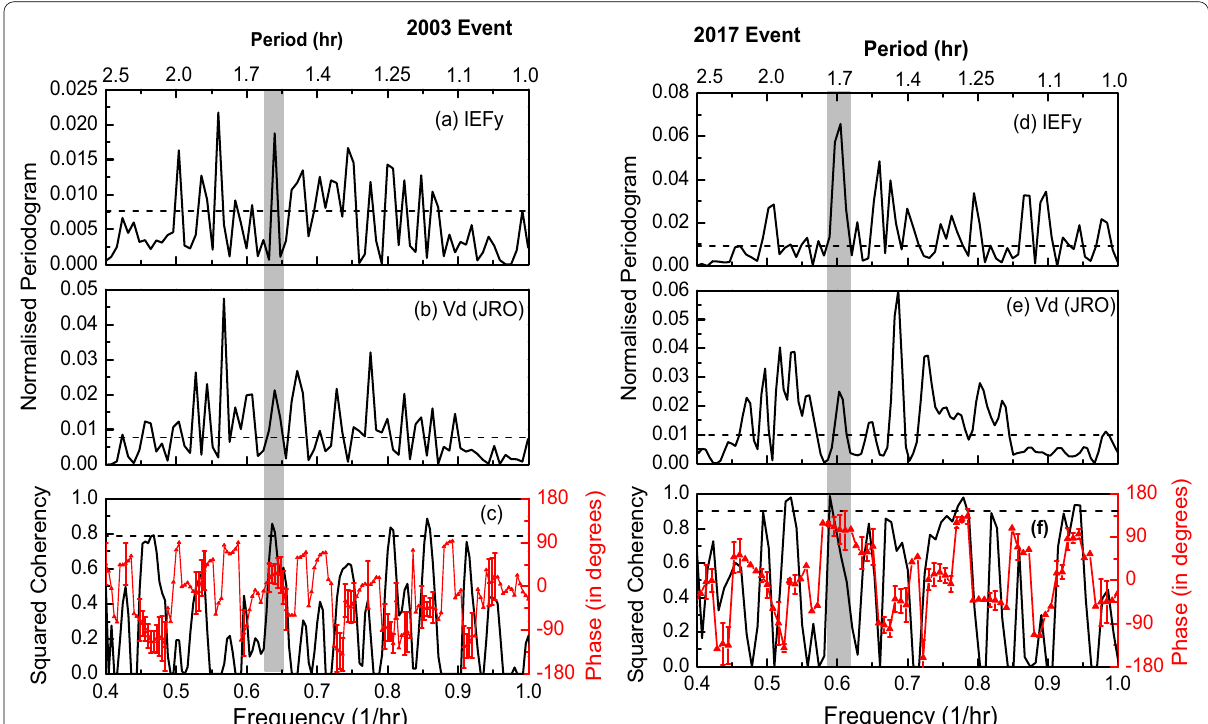
Fig. 3 Harmonic analyses of 2003 (left panel) and 2017 (right panel) events. Top three panel show the Lomb–Scargle normalized periodograms for a IEFy, and b Vd, where the black dashed horizontal line shows the 95% confidence limit. The 3rd panel represents the squared coherency (black) with the phase spectra (red) between two time series c IEFy and Vd. The horizontal black dashed lines in c , f are marked at 90% false alarm level. The rectangular grey box is marked to show the common periodic components, where the time series of IEFy, and Vd show significant coherency with stable phase relationship (essential to infer causal relationship). JRO, Jicamarca Radio